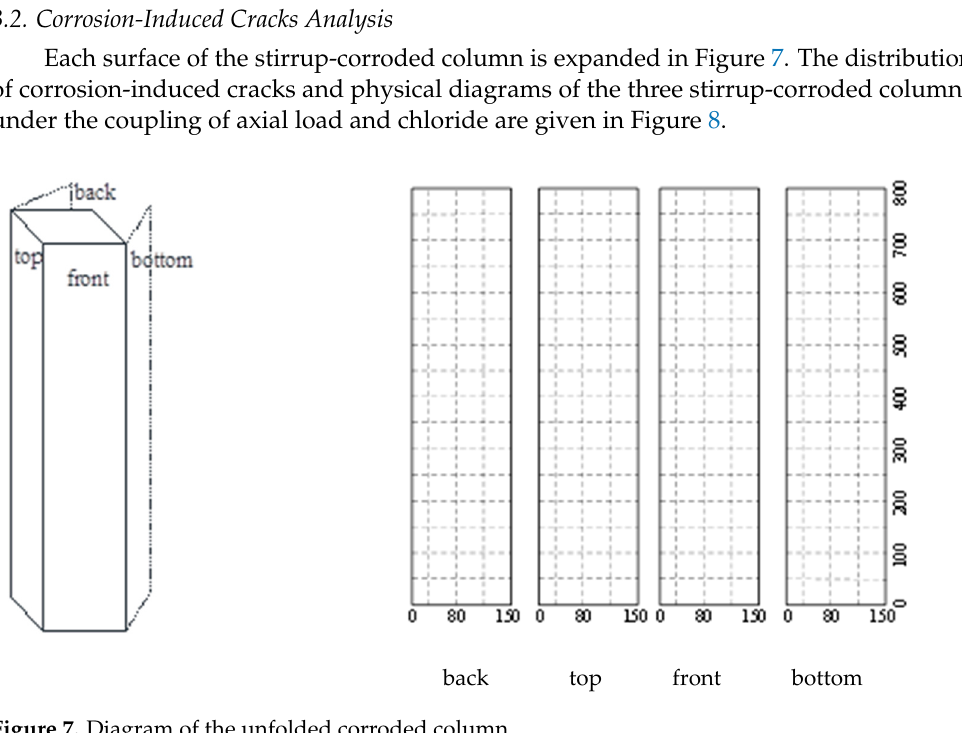
Figure 7. Diagram of the unfolded corroded column.